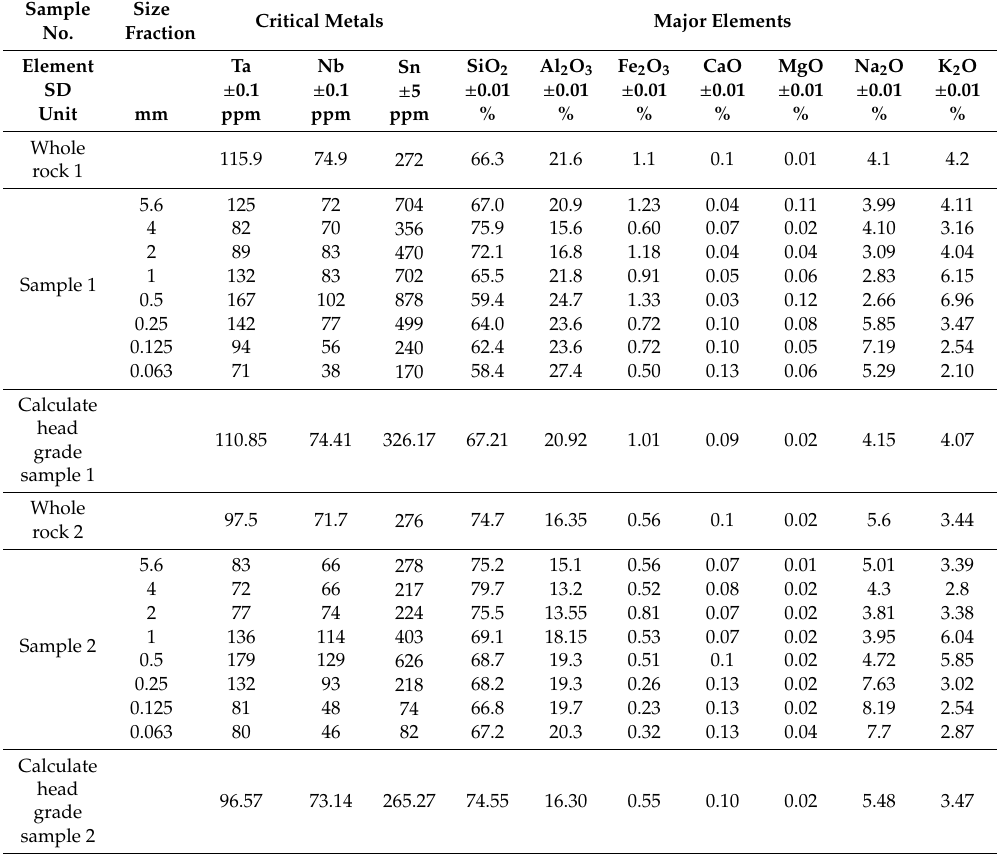
Table 2. Summary of the representative composition of the ore after compression breakage at a compression ratio of 30% for samples 1 and 2. Data for a selected number of elements. Sample